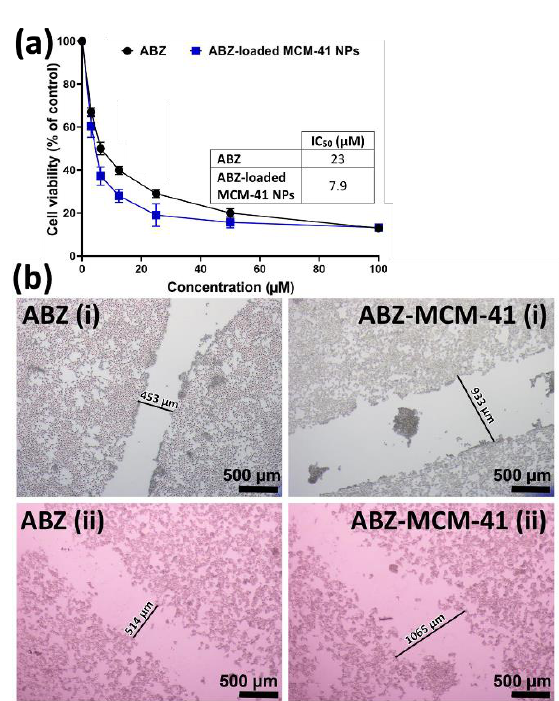
Figure 6: (a) Cell viability effects of albendazole (ABZ) and ABZ-loaded Mobil Composition of Mat- ter No. 41 (MCM-41) NPs on HepG2 liver cancer cells after 24 h. As the Figure demonstrates, the loading of ABZ into MCM-41 NPs caused a signif- icant reduction in HepG2 cell viability compared to that of the standard drug (P<0.05). The data were expressed as mean ± SD (n = 3). (b) Effects of ABZ and ABZ-loaded MCM-41 NPs on the HepG2 cells migration i) before (0 h) and ii) after (24 h) cell treatment (×40 mag). Both ABZ and ABZ- loaded MCM-41 NPs restrained the cell migration by approximately 12 %, confirming the cytotoxicity effects of ABZ and ABZ-MCM-41